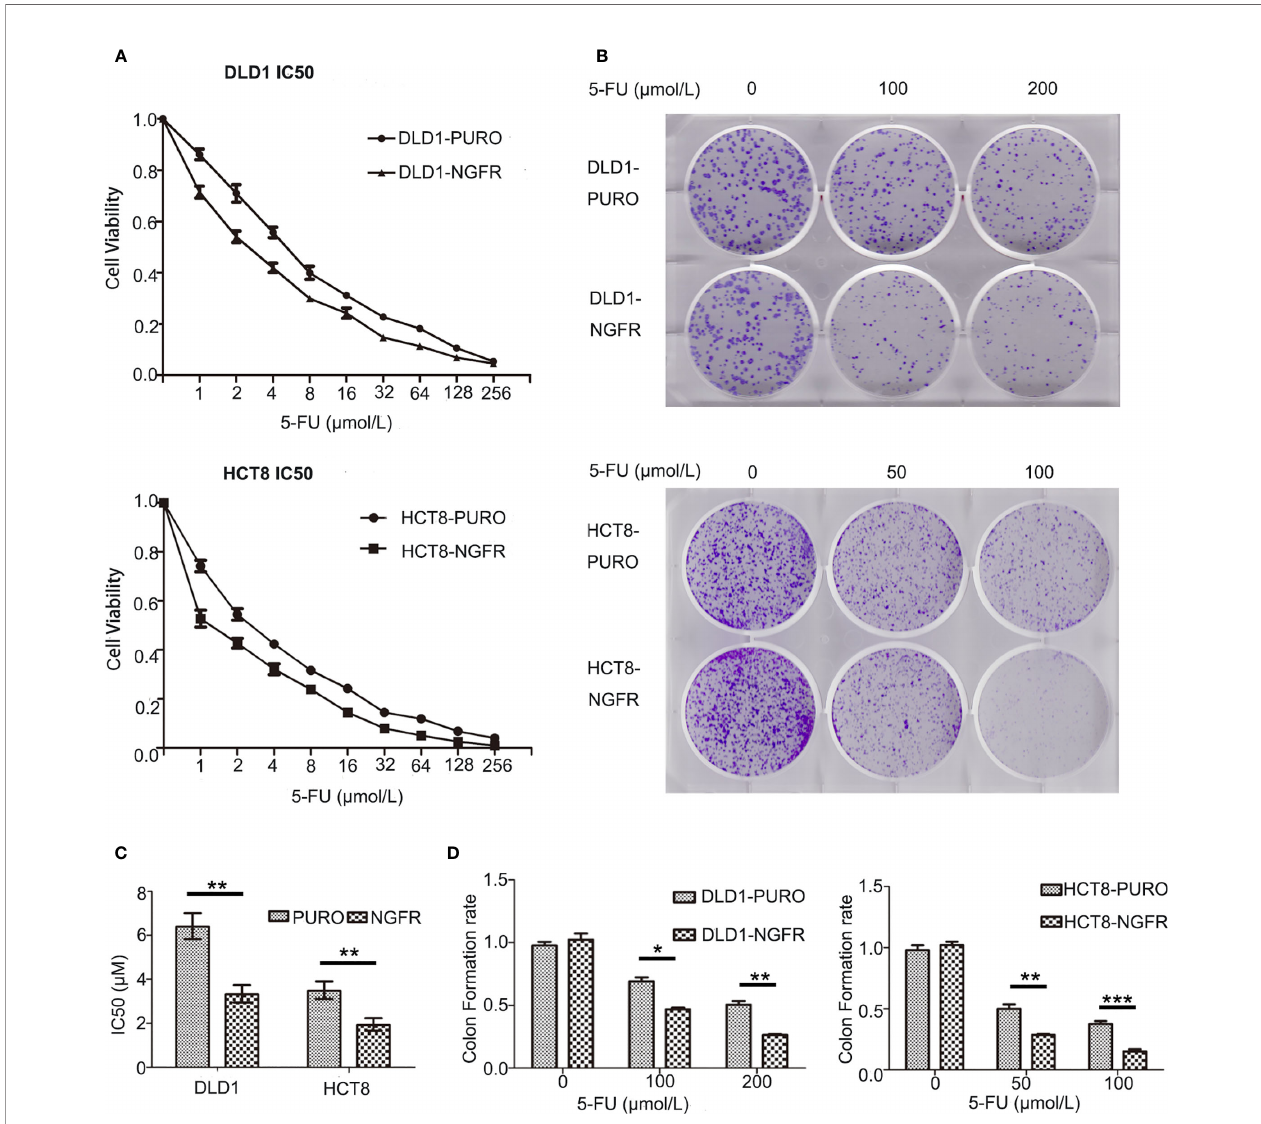
FIGURE 1 | NGFR contributed to colorectal cancer cell suppression after 5-FU treatment in vitro. (A) An MTS assay was performed to investigate the viability of overexpressed NGFR – transfected DLD1 and HCT8 cells at different 5-FU concentrations (0 – 256 µ mol/L). (B) A colony formation assay was performed using overexpressed NGFR – transfected DLD1 and HCT8 cells. (C) The IC50 values were determined as indicated on the plot (t-test; P < 0.001 for DLD1 cells, P < 0.01 for HCT8 cells). (D) Colony formation assays indicated that NGFR inhibited overexpressed NGFR – transfected DLD1 and HCT8 cell colony formation (cell viability) with increasing 5-FU concentrations (0 – 200 µ M for DLD1 cells, 0 – 100 µ M for HCT8 cells; t-test; P < 0.01 for DLD1 cells, P < 0.001 for HCT8 cells). *P < 0.05; **P < 0.01; ***P <